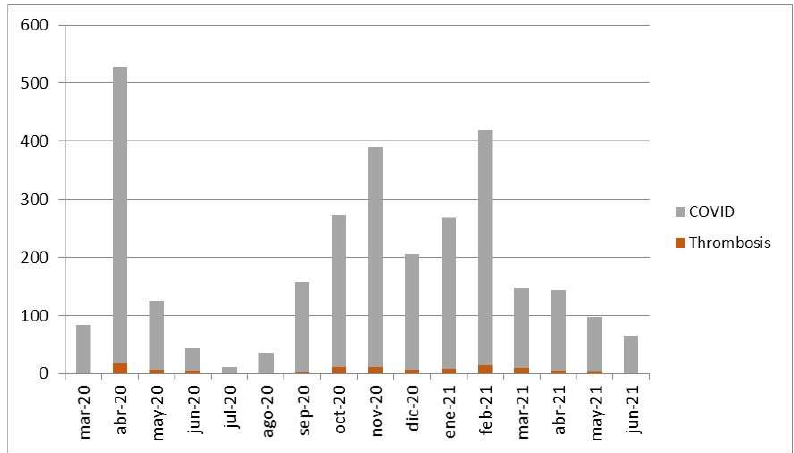
Figure 2. Evolution of the incidence rate of hospitalized thrombotic events (TEs) according to the incidence of in-hospital COVID-19 patients between 1 March 2020 and 31 August 2021.